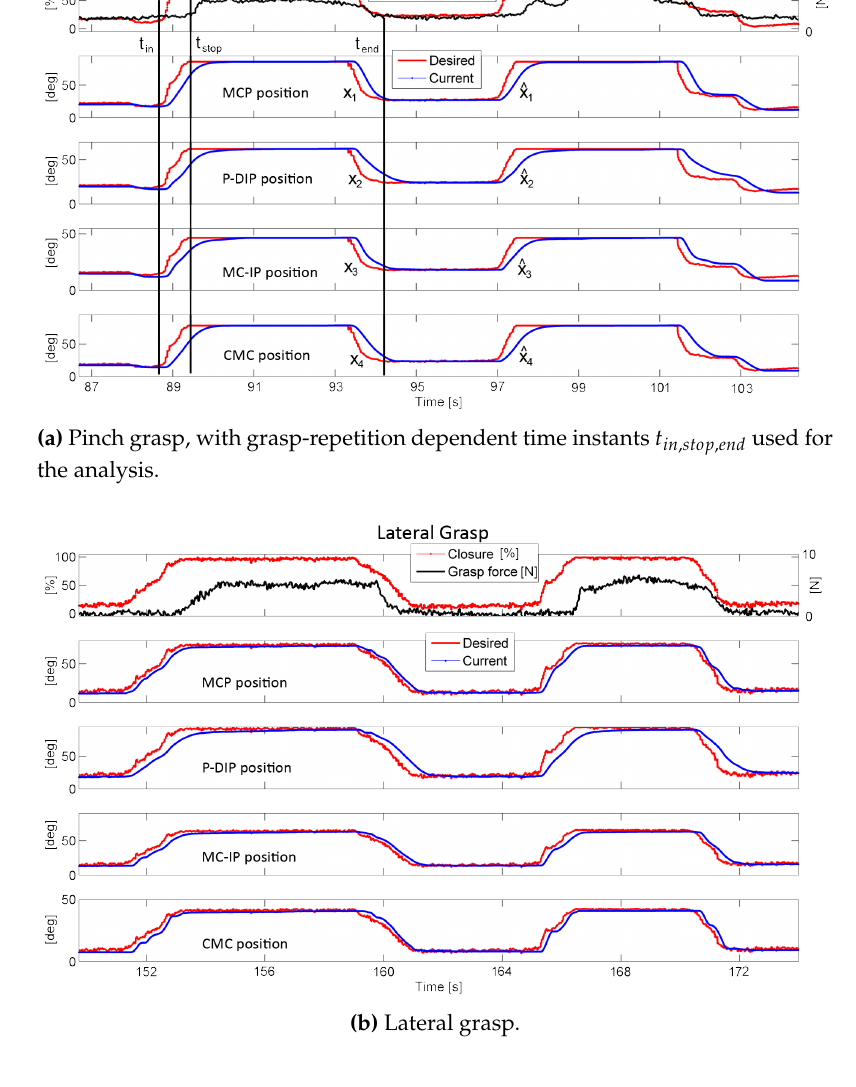
Figure 7. Example profiles of the tele-rehabilitation results. The first panel of ( a ) and ( b ) shows master desired (pre-filtering) closing percentage p , and grip force as recorded by the sensorized object, the other panels shows the slave desired (red) and measured (blue) position of the four